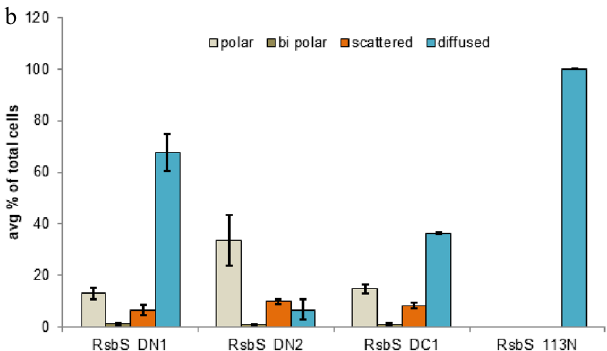
the overlay images (rightmost panel in Fig. 5a). The yellow foci, representing RsbR-RsbS co-localized complex, seemed to occur at poles more frequently in stationary phase cells. Cells with unipolar, bipolar and scattered distribution of foci were counted for RsbR, RsbS and RsbR-RsbS co- localized complexes and relative frequencies were estimated (Table S8). A summarized version of the proportions of polar and non-polar positions of the individual proteins and their complexes based on immunofluorescence data is given in Table S9a and b. Stationary phase cells showed a two-fold higher frequency of occupation at the poles compared to those in exponential phase while non-polar distribution of foci was reduced by more than half. Almost two- to three-fold higher proportion of RsbR and RsbS foci became part of the complex under the